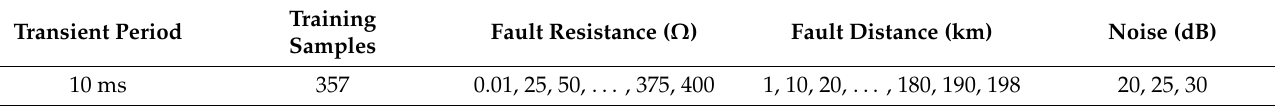
Table 5. Internal fault scenarios for training